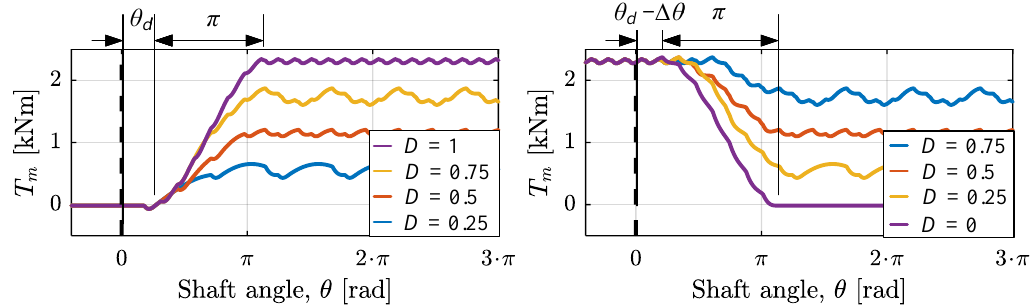
Figure 16. Step-up response ( left plot ) and step-down response ( right plot ) using FSDS in the position